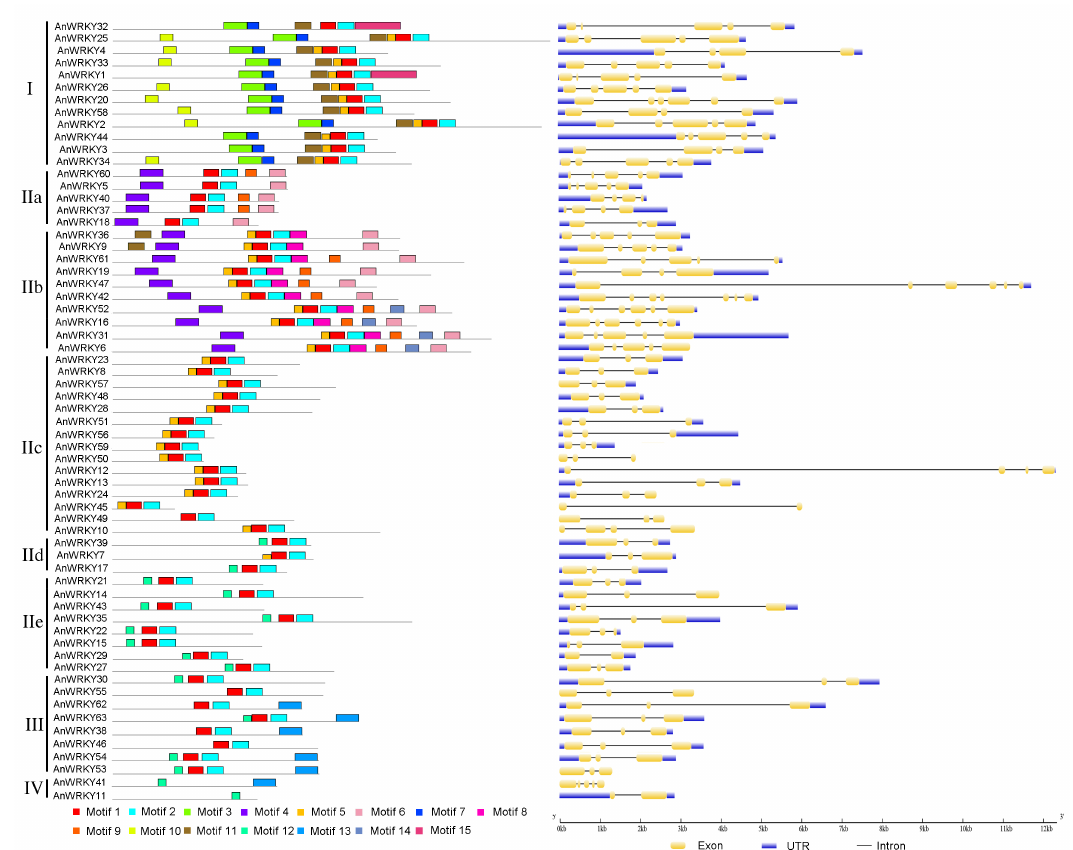
Figure 2. Conserved motifs and exon–intron distribution of AnWRKY genes. Conserved motifs (left panel) and exon–intron structure (right panel) were analyzed using MEME and GSDS software, respectively. The di ff erent groups and subgroups are indicated at the far left. Motifs 1 to 15 are indicated by di ff erent colored boxes in the left panel. In the right panel, introns and exons are represented by thin black lines and thick yellow lines, respectively. Thick blue lines represent UTRs. Note that the two panels are drawn to di ff erent scales: protein length on the left and DNA length on the